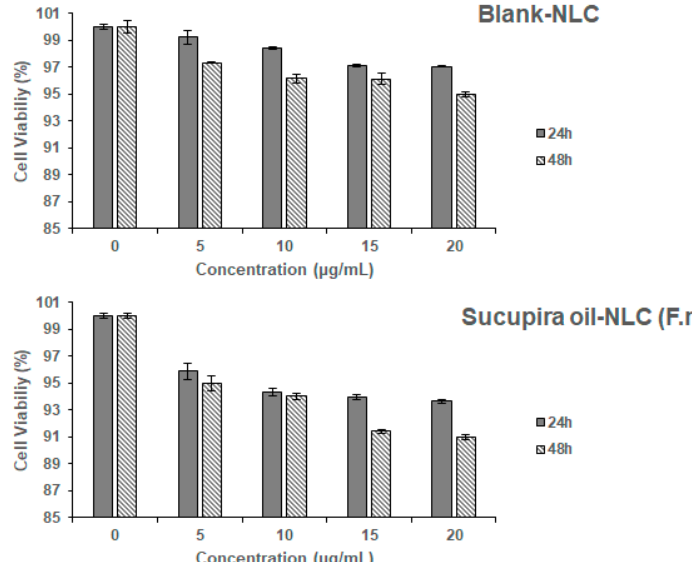
Figure 4. Caco-2 cell viability after 24 h and 48 h of exposure to different concentrations of Blank-NLC (upper panel) and sucupira oil-loaded NLC (lower panel). Results of cell viability are expressed as percentage of control cells (non-exposed cells) and as arithmetical means ± standard deviations (n = 3 different experiments). Cell viability was assayed by AlamarBlue ® reduction assay, for details see methods.